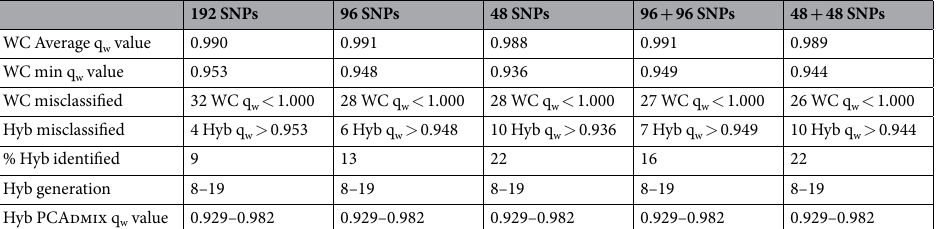
32 WC q w < 1.000 28 WC q w < 1.000